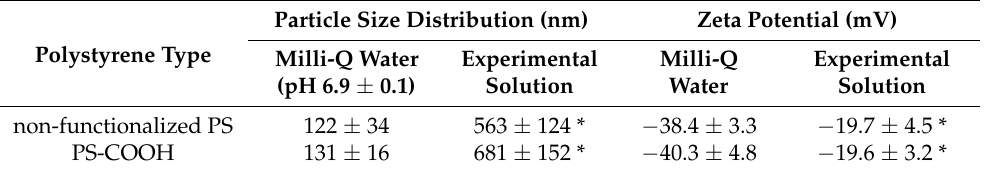
Table 1. Particle size distribution ( n = 3, mean particle diameter ± SD) and zeta potential of PS